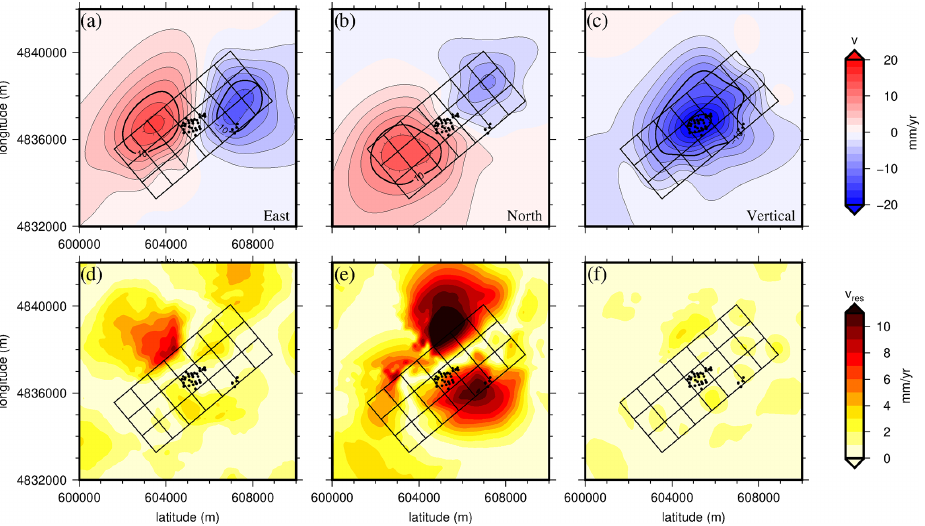
Figure 12. (a) East, (b) north, and (c) vertical components of the deformation from the optimal model with the associated residuals ( d , e , and f , respectively). The mean values of residual norms are estimated to 1.7, 3.4, and 0.7mmyr − 1 for the east, north, and vertical components,